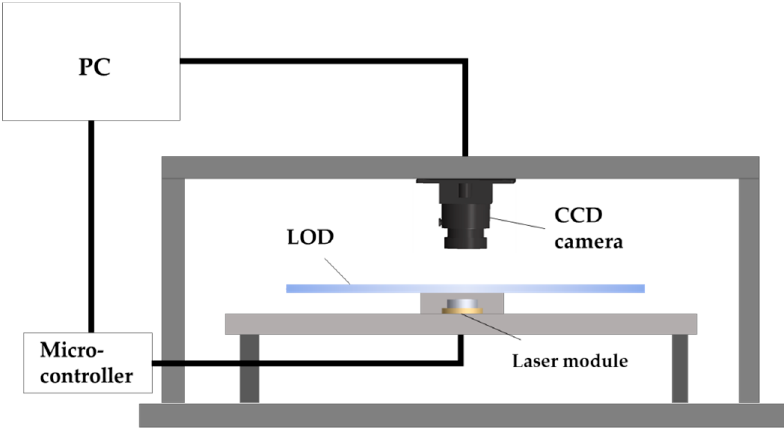
Figure 2. Schematic representation of the data acquisition and analysis module.